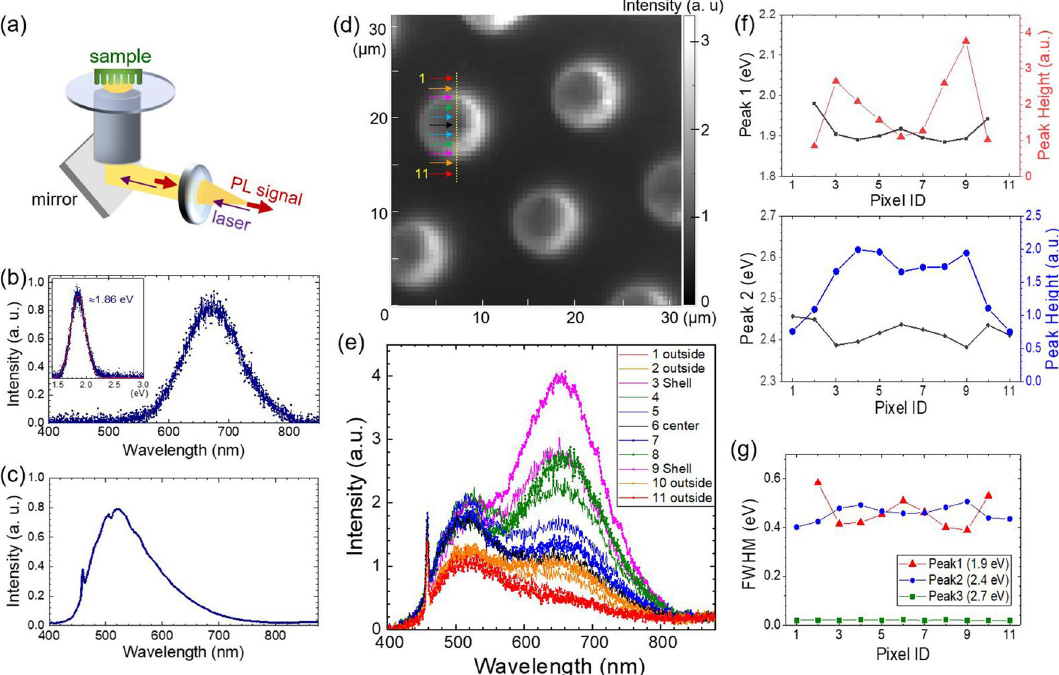
Figure 3. ( a ) A schematic of inverted confocal photoluminescence (PL) set-up, where a laser beam (λ = 405 nm, power = 1.5 mW) is illuminated through a high numerical aperture (NA) objective, and the emitted PL signals are collected through the same objective lens and detected by a charge-coupled device (CCD) camera/ spectrometer. ( b ) A PL spectrum of vertically-aligned Si pillar array obtained with an air objective lens (40× ; NA = 0.6). ( c ) Background PL luminescence (10 s integration time) induced by the stack of layers of oil/coverslip/oil/objective lens without the pillar specimen. ( d ) A high-resolution panchromatic PL image (400 nm–880 nm) collected with an oil immersion objective lens (100× ; NA = 1.4). ( e ) A series of PL linescans extracted from the yellow line on the image. ( f , g ) show the extracted peak information from the multiple Gaussian curve fitting of the PL linescans: Peak 1 (650 nm; 1.9 eV), Peak 2 (520 nm; 2.4 eV) and Peak 3 (460 nm; 2.7